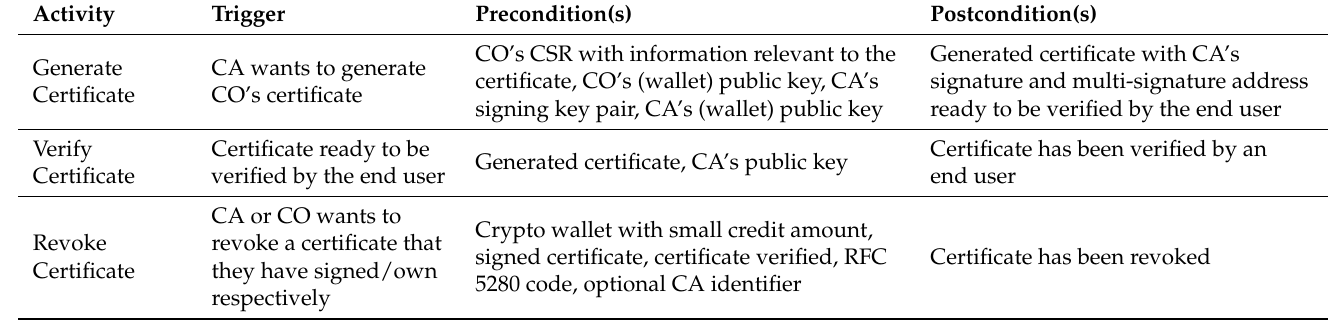
Table 2. Top-level behavioral interface model of BlockVoke.